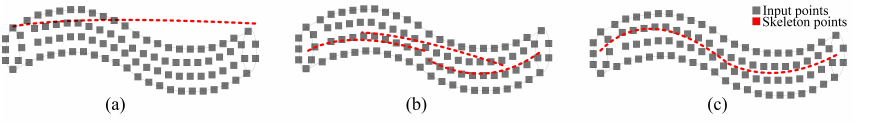
Figure 8. Evaluation of the skeleton extraction. ( a ) Low accuracy. ( b ) Low effectiveness. ( c ) Desired